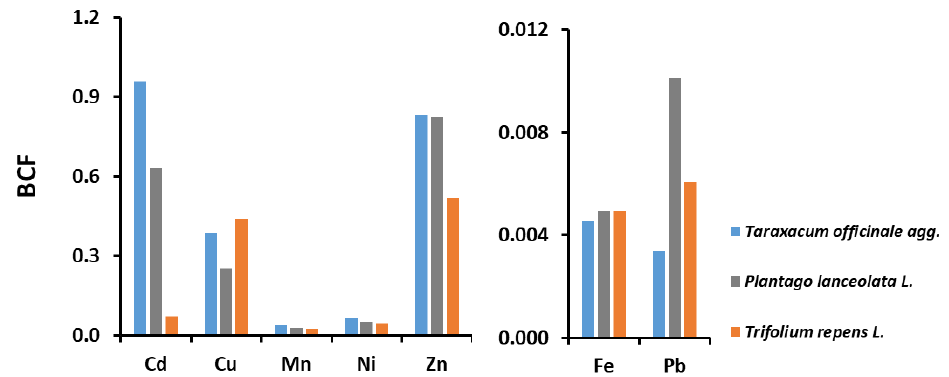
Figure 4. Bioconcentration factors (BCFs) for heavy metals (Cd, Cu, Fe, Mn, Ni, Pb and Zn) in three plant species ( Taraxacum officinale , Plantago lanceolata and Trifolium repens ) collected in the Varaždin area.